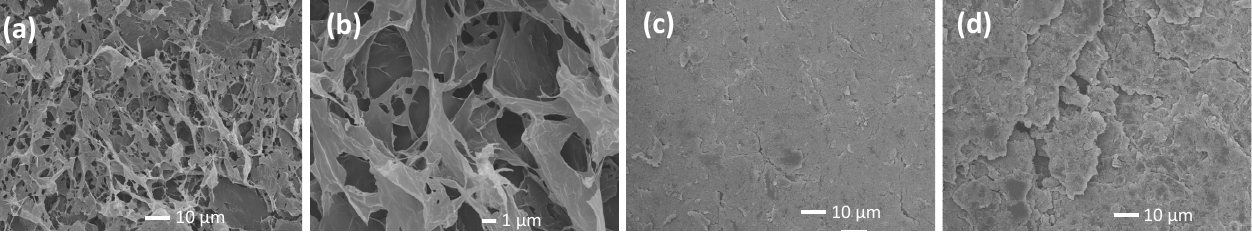
Figure 3. SEM micrographs of the working electrodes with di ff erent coatings: ( a ) Electrodeposited 3D GO–CNT layer ( b ) is the zoomed-in micrograph; ( c ) Bare carbon electrode; ( d ) 2D graphene.